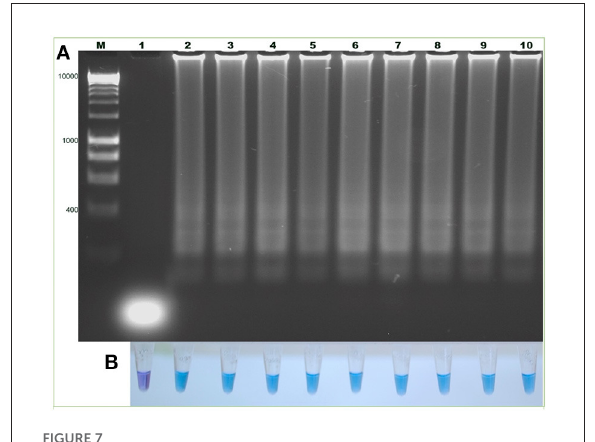
FIGURE7 Detection of the ama-1 gene in B. bigemina strains using the LAMP technique. (A) Electrophoresis in 1.2% agarose gel, stained with red gel. (B) Colorimetric test with hydroxynaphthol blue. Lanes: M) Molecular size marker in bp: (1) Negative control. Mexico: (2) Chiapas, (3) Colima, (4) Jalisco, (5) Nayarit, (6) Queretaro. Argentina: (7) S1A, (8) S2P, (9) S3P. (10)